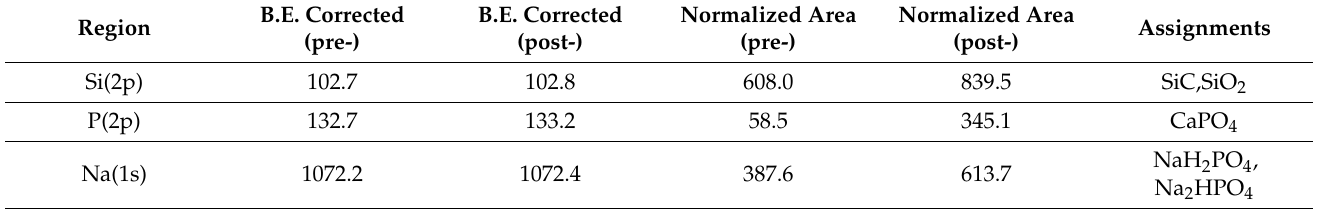
Table 4. Assignment related to Si2p, P2p, and Na1s peaks.